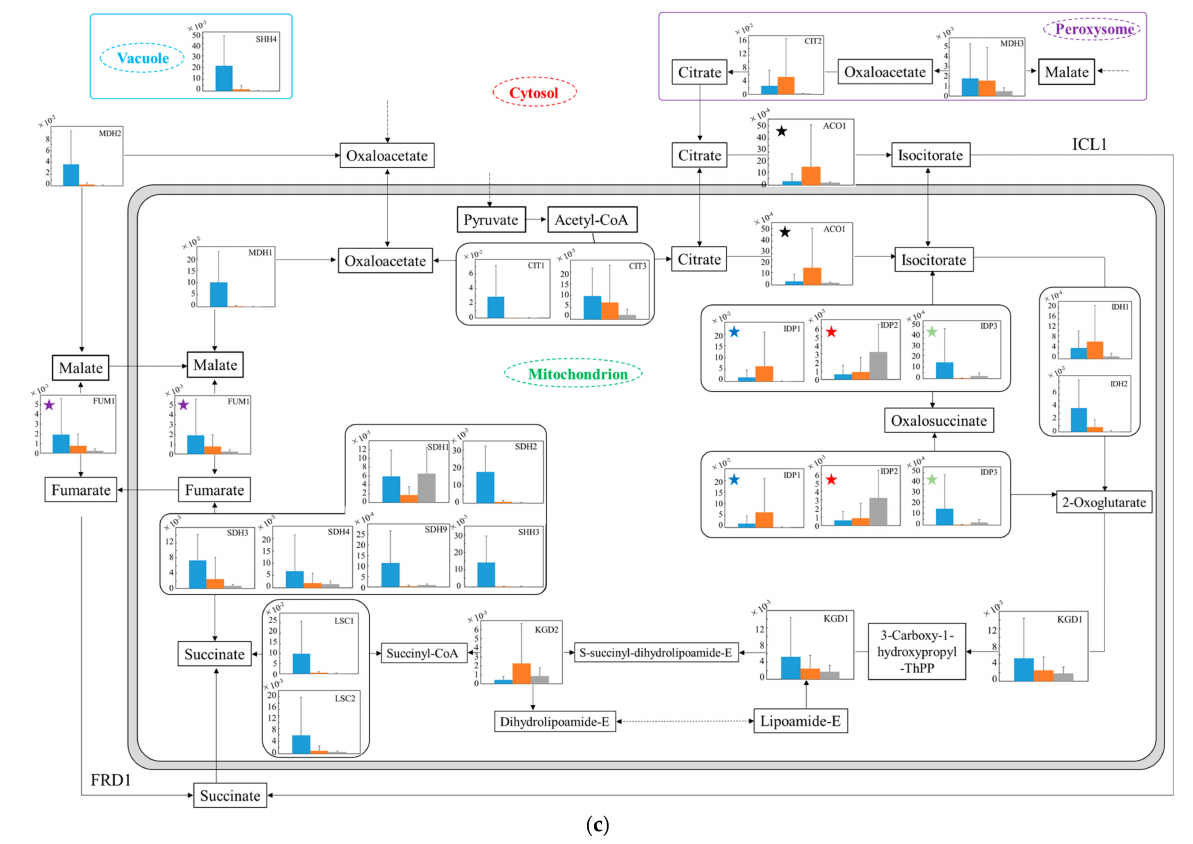
Figure 5. Relative quantification of mRNA of wildtype and no.7 in SD and in SD/YNBG under aerobic conditions. Shown data are the relative mRNA levels normalized by the level of RDN18 as a housekeeping gene and by level of each gene of wildtype and no.7 under different media (SD and YNBG) at the exponential phase. The relative mRNA levels of wildtype in SD, no.7 in SD, and no.7 in YNBG are shown as blue, orange, and gray bars, respectively. Error bars indicate the SD of six replicate experiments ( n = 6). The metabolic map is divided into three parts mainly including the ( a ) glucose–glycerol pathway, ( b ) pyruvate-ethanol pathway, and ( c ) TCA cycle. The same-colored star marks in same figures mean transcription levels of the same enzymes; same-colored circles marks in ( a , b ) mean transcription levels of the same enzymes, especially ALDs and